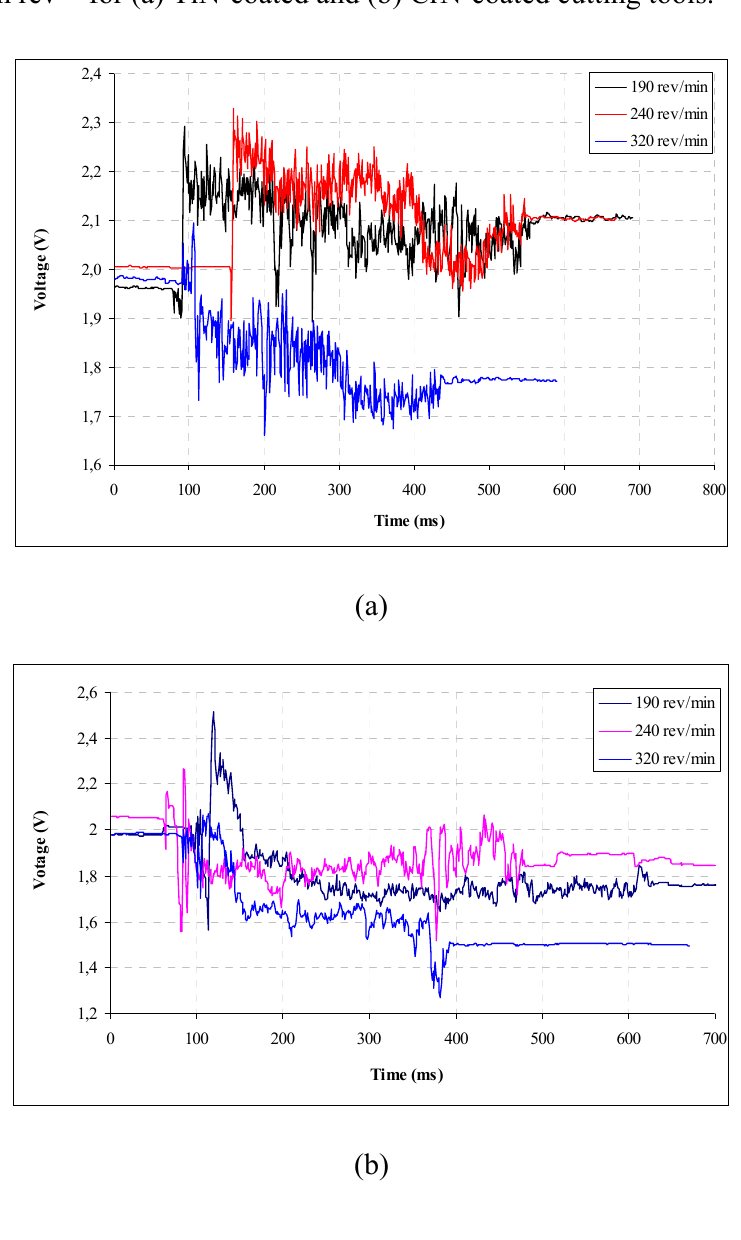
Figure 4 . Comparison of wear properties at different rotational speeds at a feed speed of 0.081 mm rev -1 for (a) TiN-coated and (b) CrN-coated cutting